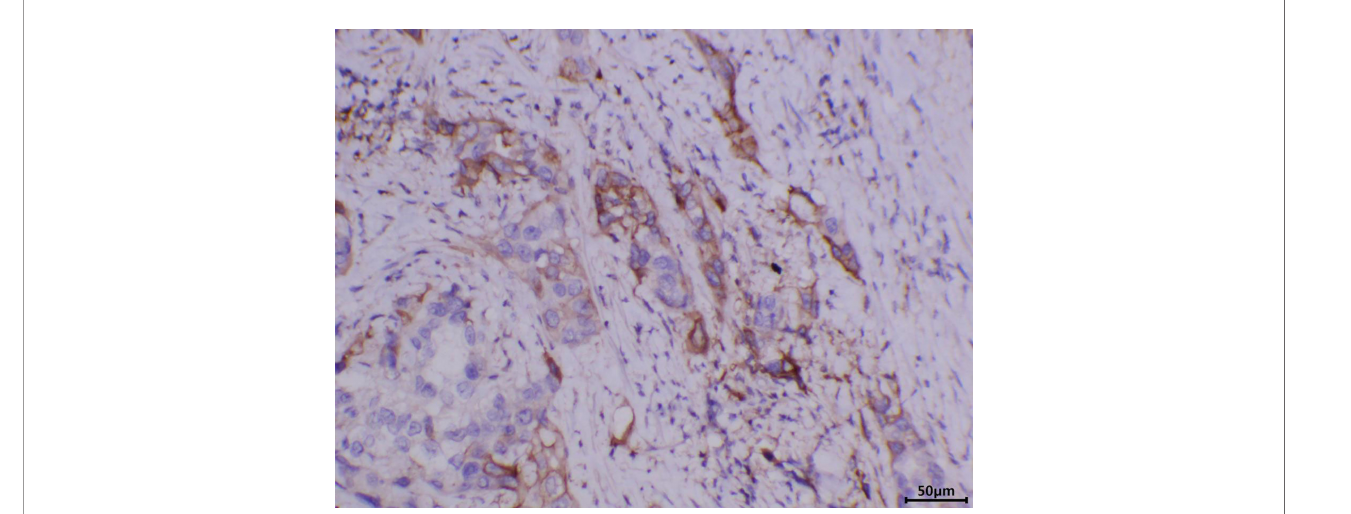
FIGURE 2 | Immunohistochemistry showing that PD-L1 was expressed in the primary penile squamous cell carcinoma tissue, TPS=10%.